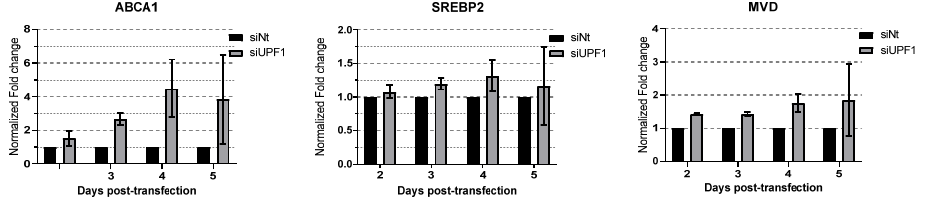
Figure A1. RT-PCR results of cholesterol pathway genes ABCA1, SREBP2, MVD from two inde- pendent time-course experiments (duplicated each) of RNA collected at 48-, 72-, 96- and 120-h post-transfection with siUPF1 and siNT. Error bars represent Mean ± SD. For all RT-PCR studies, indi- vidual samples are run in triplicate.